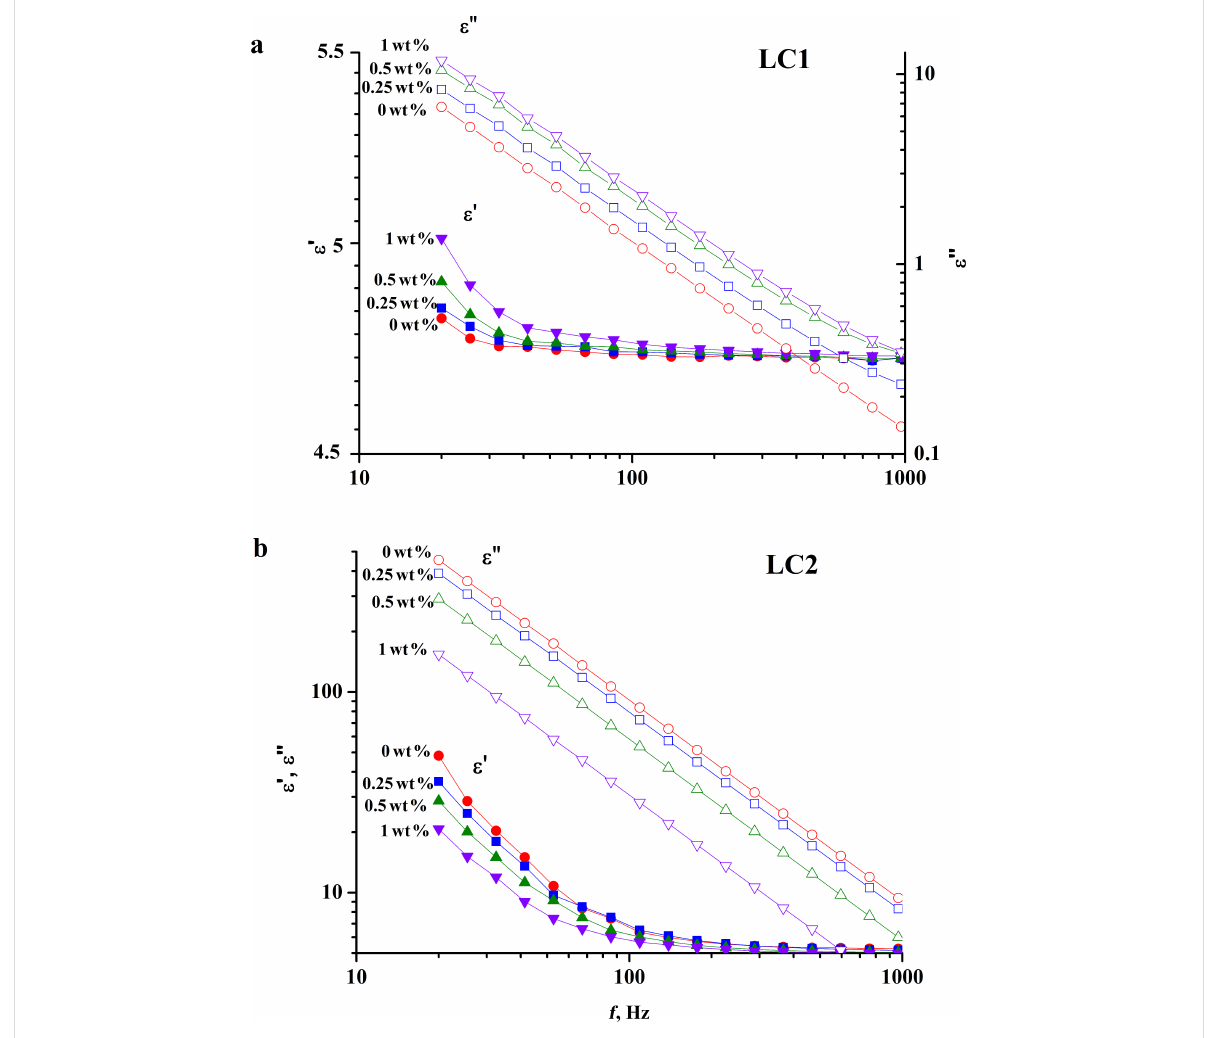
Figure 1: The low frequency spectra of the real and imaginary parts of the dielectric permittivity for LC1 (a), LC2 (b), and their composites.